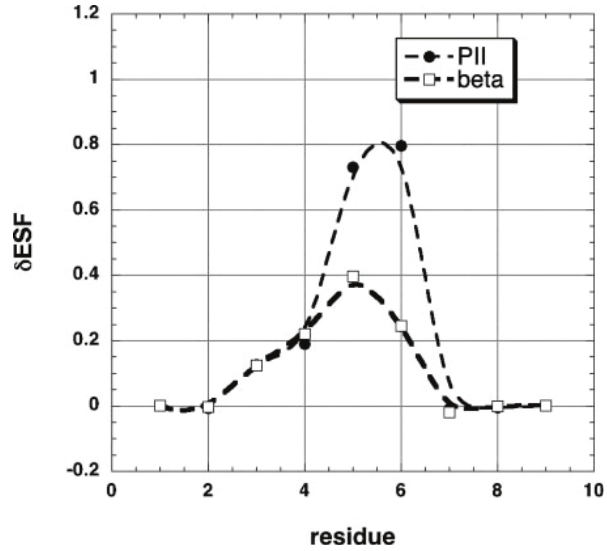
Figure 19. Representation of the change of the electrostatic solvation free energy induced by substituting the fifth alanine residue of a hepta-alanine peptide by valine. Changes are plotted for pPII and (cid:8)-strand conformations, as indicated. (Taken from ref. [85] with